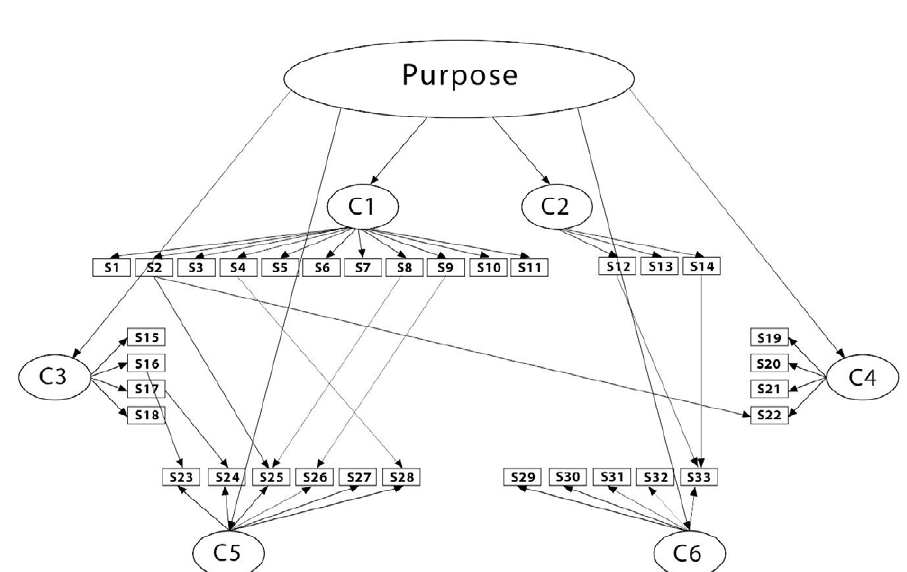
Fig. 3: The relationships between criteria and sub-criteria (ANP Fig.3: The relationships between criteria and sub-criteria (ANP structure)